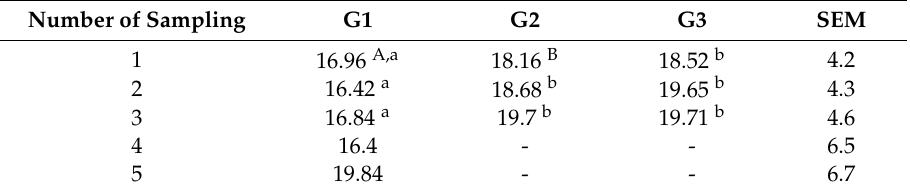
Table 2. Changes in dry matter content (%) in sheep’s milk from the Group 1 (lambing in February–milked from April to August, Group 2 (lambing in June–milked from August to October), Group 3 (lambing in June–milked from August to November and melatonin-treated before 6 weeks parturition).